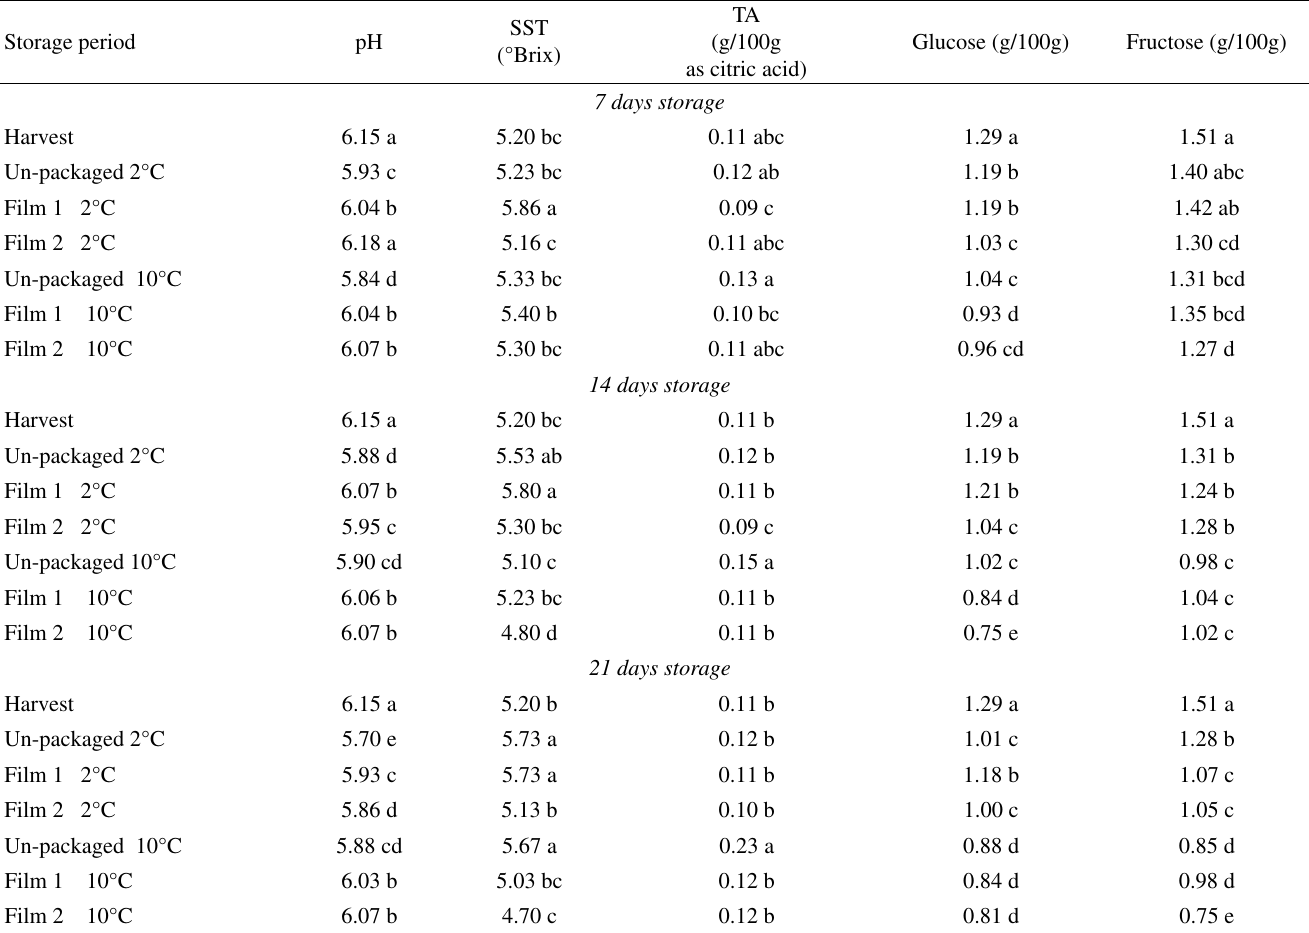
Table 1 - Influence of film packaging (Film 1, Omnifilm PVC film; Film 2, Bolphane BX polyolefinic film) and storage conditions on pH, total soluble solids (TSS), titratable acidity (TA), sucrose and fructose in asparagus